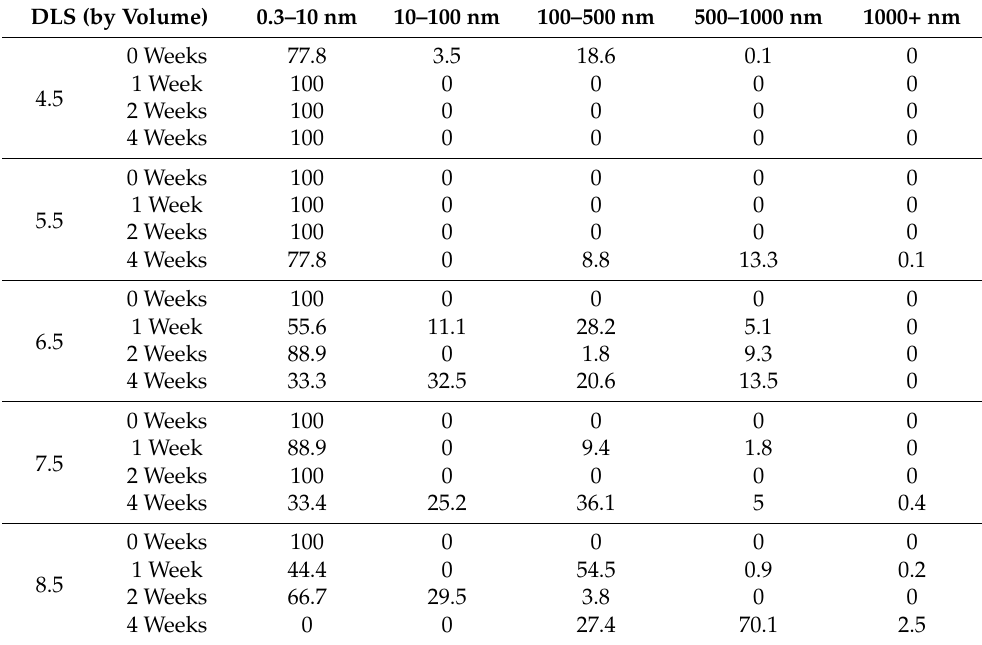
Table 1. Particle size distribution was determined by dynamic light scattering (by volume)